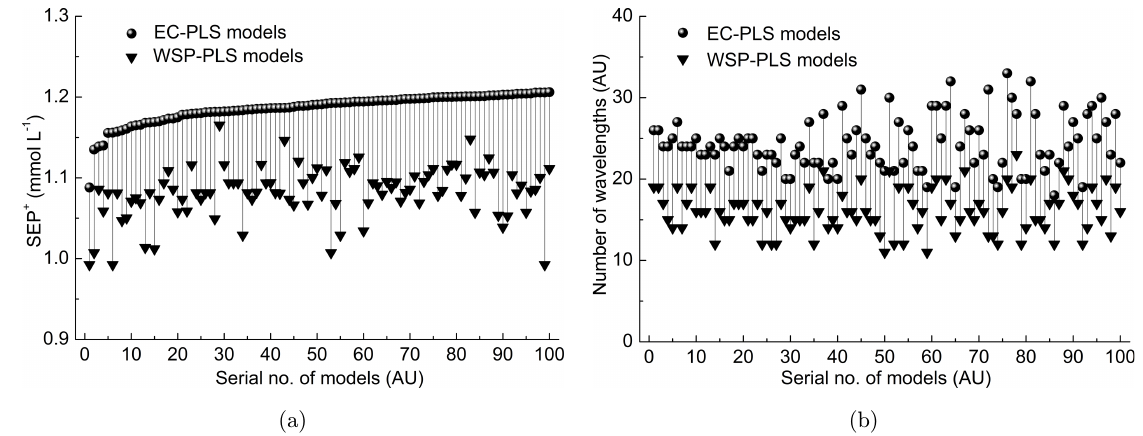
Fig. 3. Top 100 EC-PLS models and the corresponding WSP-PLS models: (a) SEP þ and (b) number of wavelengths.